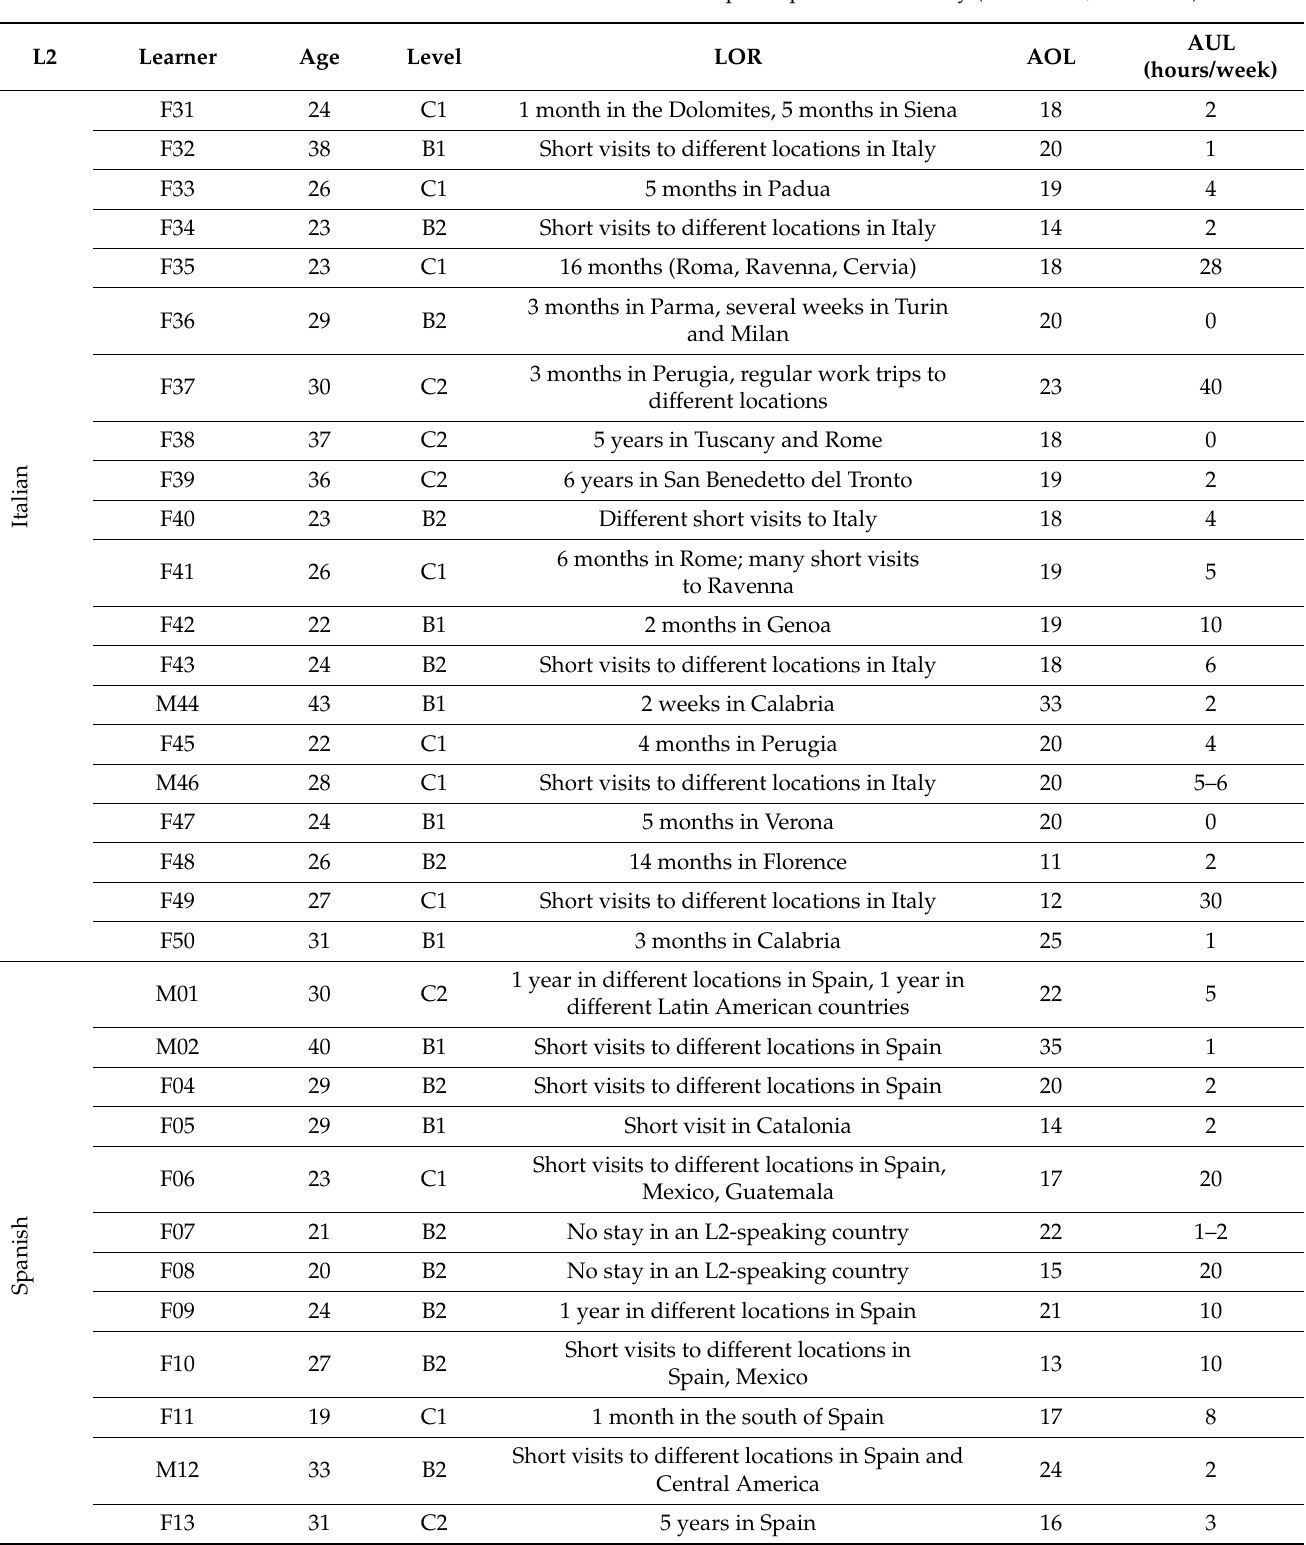
Table A1. Overview of the learners who participated in the study (F = female, M =